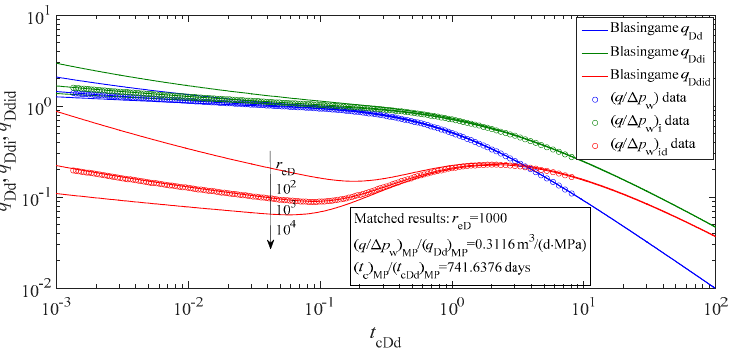
Figure 7. Normalized rate functions and modified normalized rate functions for CPP case of 70 MPa Δ = p . w